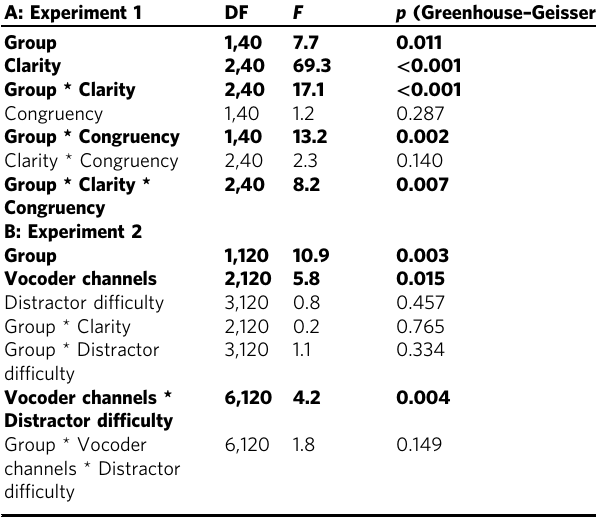
Statistically signi fi cant rows at p < 0.05 are indicated in